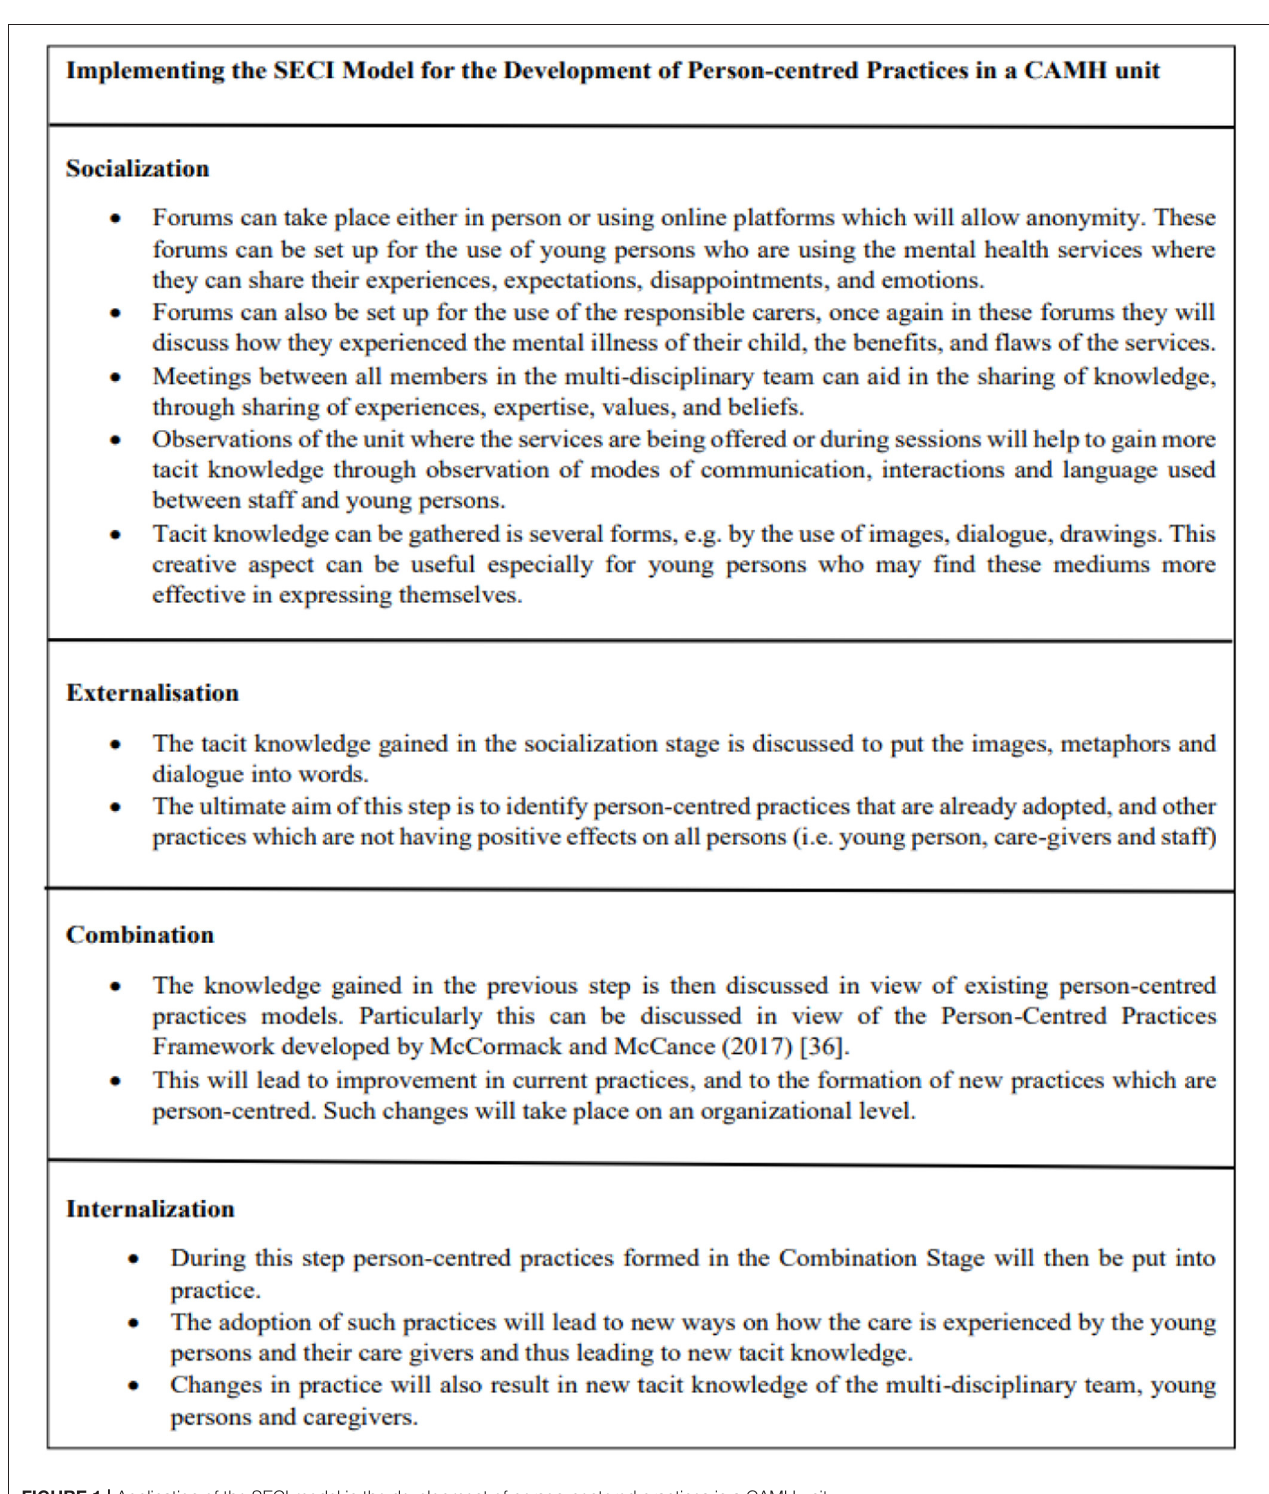
Frontiers in Rehabilitation Sciences |